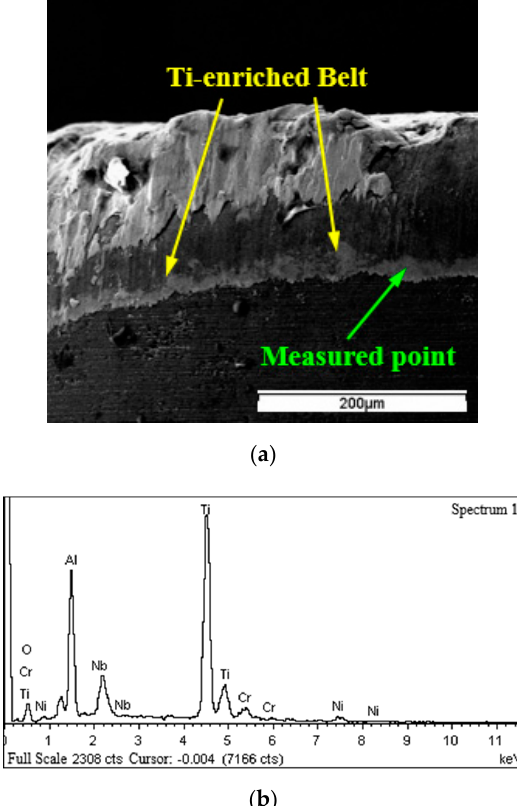
Figure 7. Ti − enriched belt on the rake face of WG300: ( a ) SEM micrograph; ( b ) EDS spectrum.